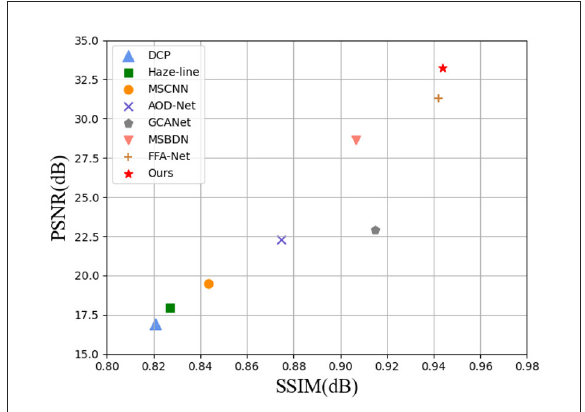
FIGURE1 Image dehazing on the RESIDE dataset (Li et al., 2018). Under different evaluation indexes, the performance of our method is the most advanced (SSIM on x-axis and PSNR on y-axis) when compared with several advanced